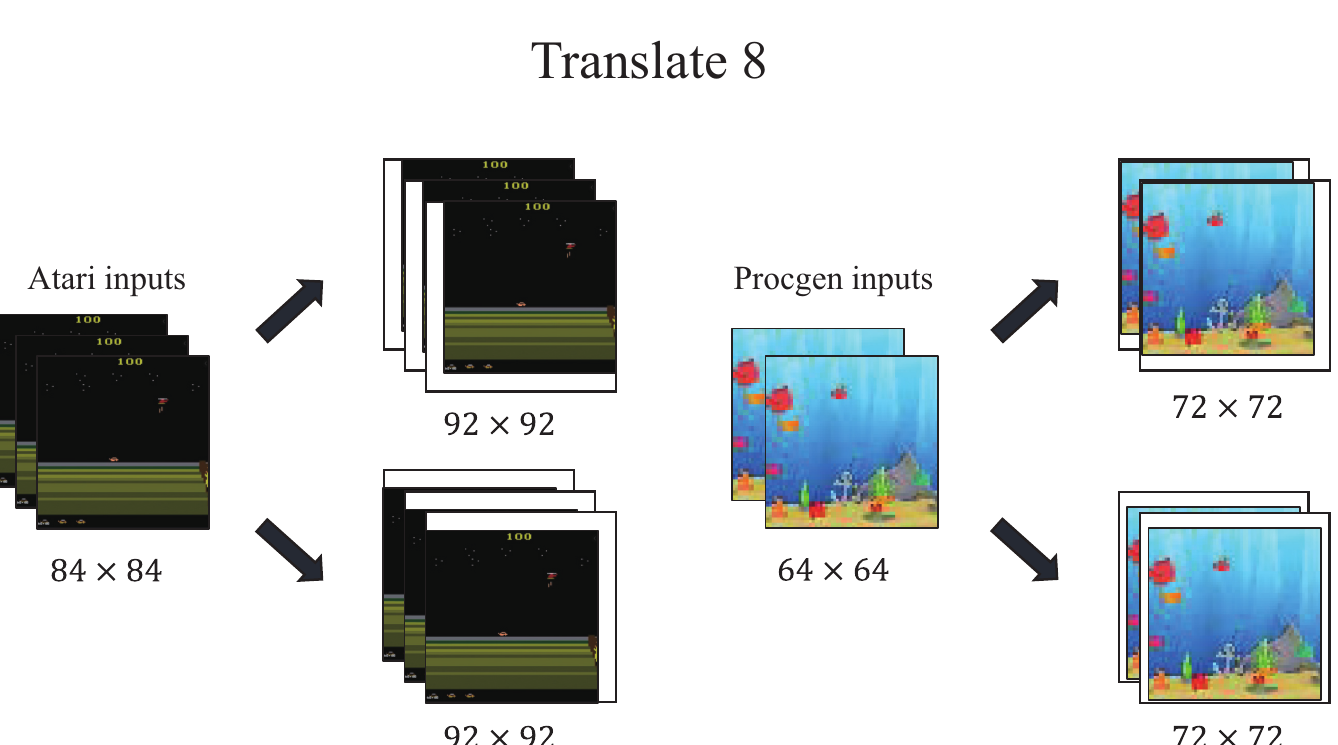
Fig 4. The frame-stacked inputs. For Atari agents, four sequentially frame-stacked observations are translated from 84x84 to 92x92 pixels with zero pads. Likewise, for ProcGen agents, two frame-stacked observations are translated from 64x64 to 72x72 pixels [22].